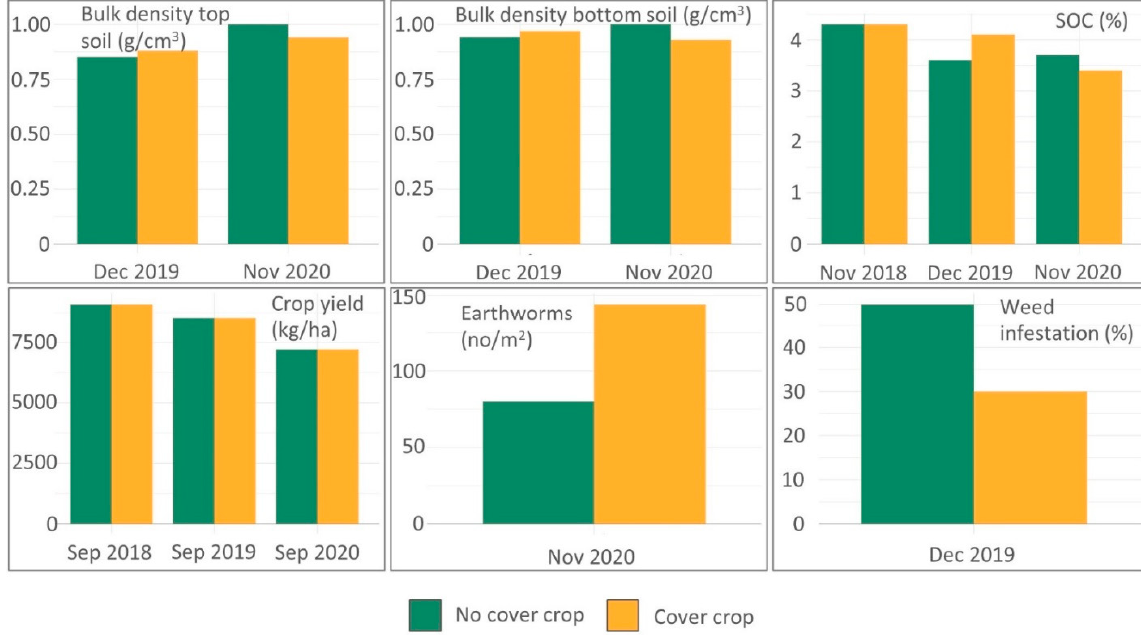
Figure 6. Soil properties in no vetch and vetch plot at the vineyard site during the 2.5-year monitoring.